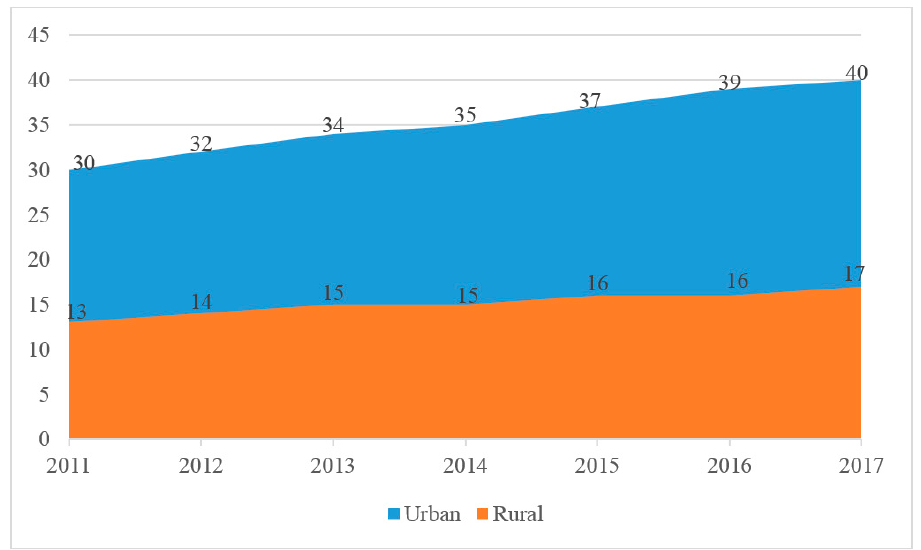
Figure 1. Number of licensed doctors in urban and rural areas of China from 2011 to 2017. Data from China Bureau of Statistics.